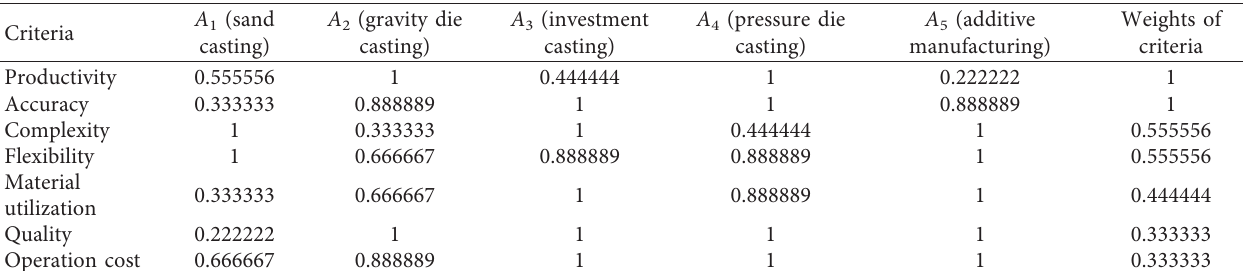
Table 6: Normalized decision matrix of the collected ratings of the manufacturing process alternatives.